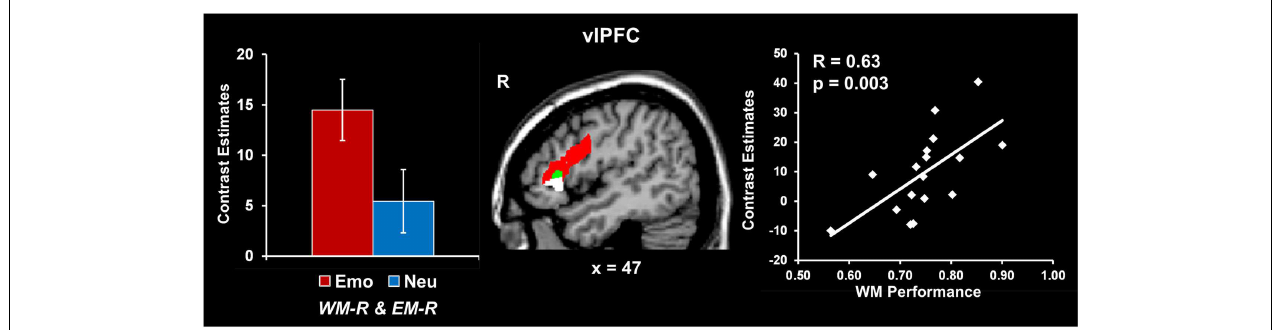
emotional distraction (left vlPFC) and linking coping mechanisms with increased subsequent EM for the distracting information (right vlPFC).The bar graph shows contrast estimates for the peak voxel in right vlPFC for the comparison between emotional and neutral stimuli associated withWM success and later remembered (Talairach coordinates: x = 43, y = 23, z = 14).The scatter plot shows the co-variation between brain activity and WM performance, as extracted from the peak voxel of the green blob (Talairach coordinates: x = 47, y = 24, z = 7).The activation maps are superimposed on a high-resolution brain image displayed in sagittal view ( x indicates theTalairach coordinate on the left-right axis of the brain). vlPFC, ventrolateral PFC; Emo/Neu WM-R and EM-R , emotional/neutral distracters that did not impairWM and were later remembered. Error bars represent standard errors of